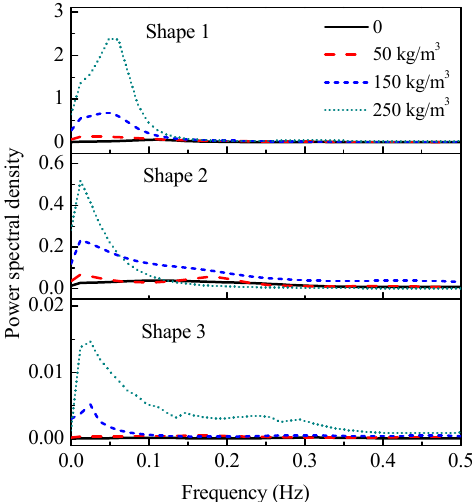
Figure 12. Relationship between power spectral density and frequency at 2.20 m upstream with different sediment concentrations.